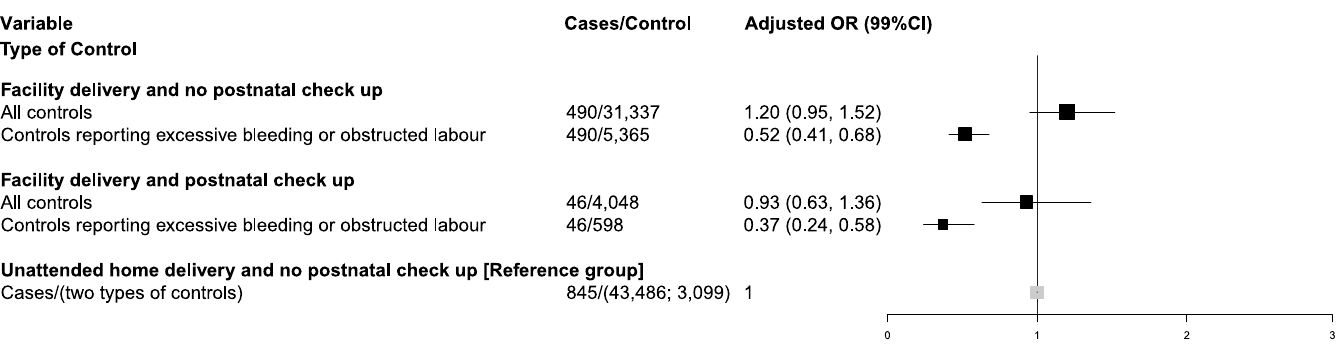
Fig 3. Adjusted odds ratios for neonatal death for facility deliveries by different controls, India 2001 – 04. Note: Postnatal check ups were measured as home visits within two weeks after delivery. Postnatal check ups occurring at health facilities were not measured. There is no significant interaction effect between home postnatal visits alone with place of delivery.